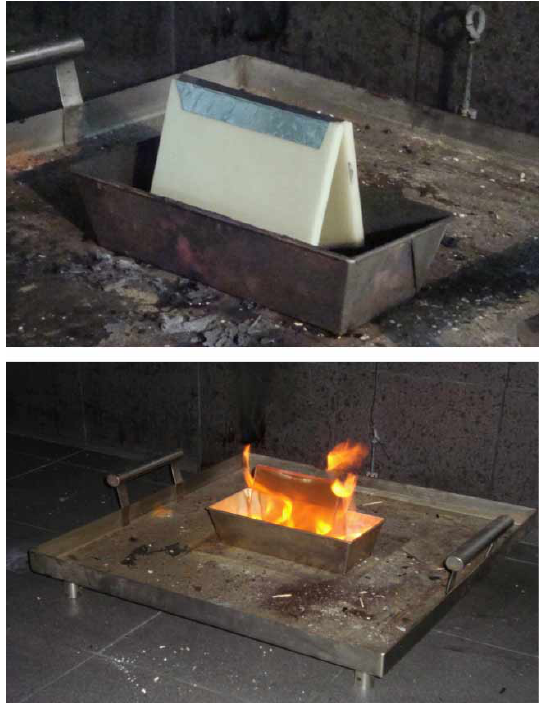
Fig. 6. A modified polyester sample prepared for the test (top) and an unmodified sample during the test (bottom)